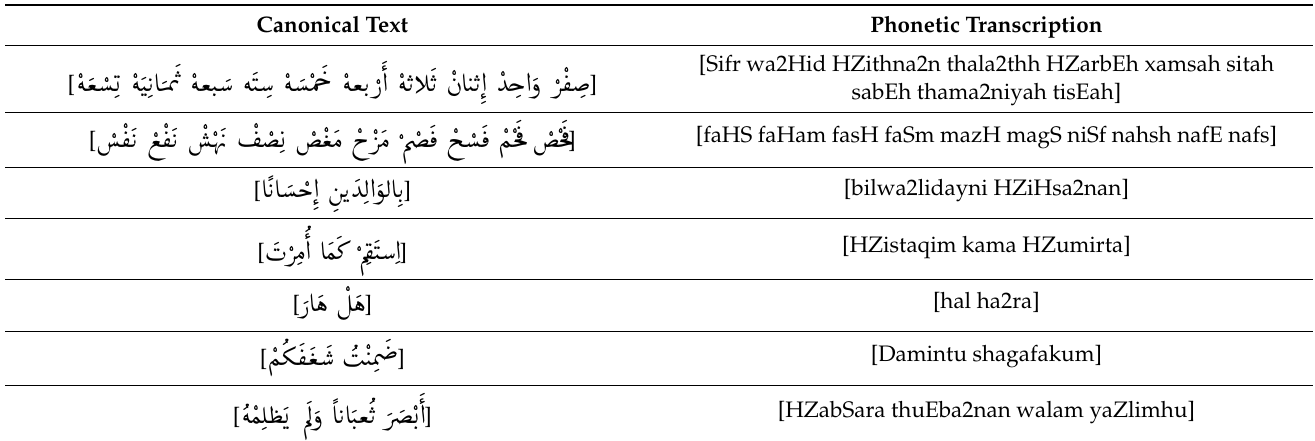
Table 1. Examples of the selected text.